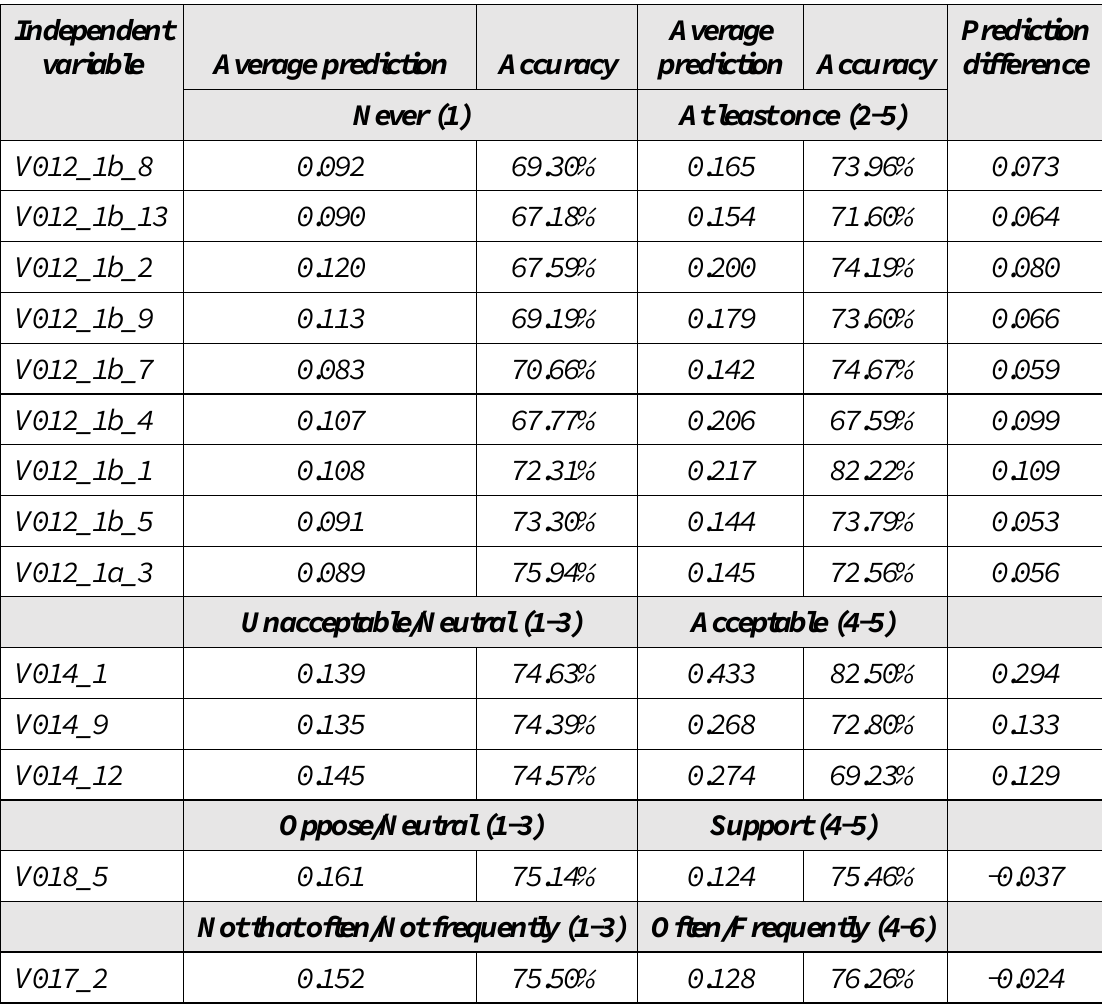
Table 6. Influence of each variable on DNN